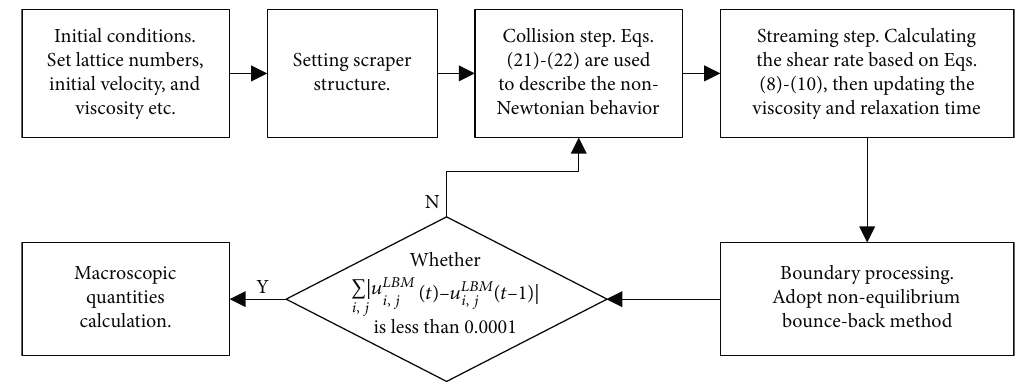
Figure 6: Flow chart of the simulation.